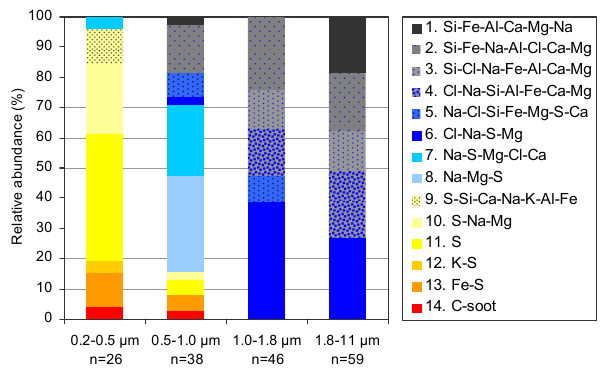
Figure 8. Relative abundances (%) of 14 particle groups in the four size fractions Fig. 8. Relative abundances (%) of 14 particle groups in the four obtained by the TEM/EDX individual particle analysis from the Battelle sample that was collected between 11:37 and 15.05 local summer time during the episode on 25 May. size fractions obtained by the TEM/EDX individual particle analy- sis from the Battelle sample that was collected between 11:37 and